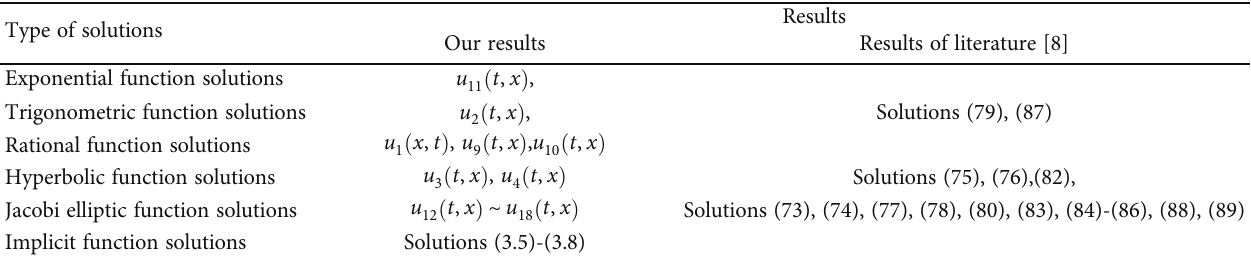
Table 1: Comparison between my results and literature